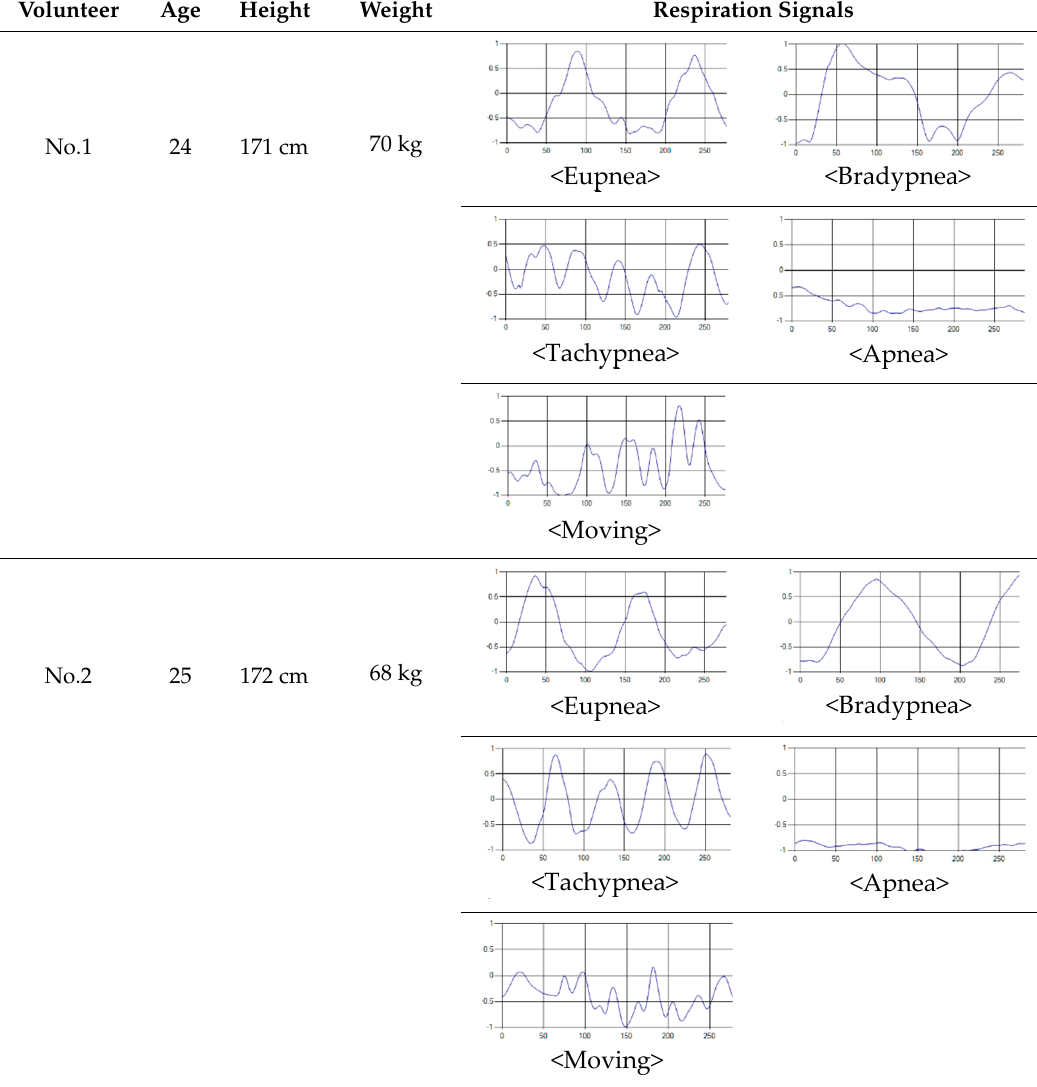
Table 7. Data provider’s body information and five respiration patterns.